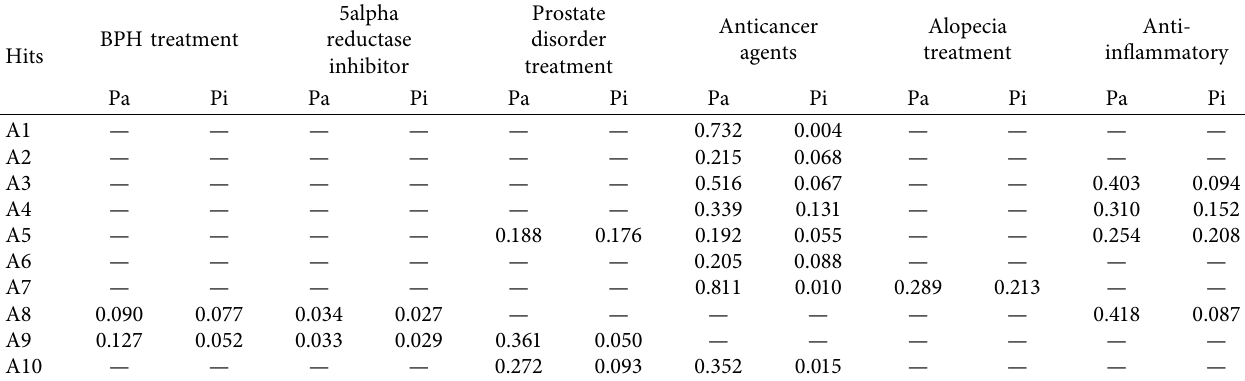
i , LE, Le_Scale, FQ, and